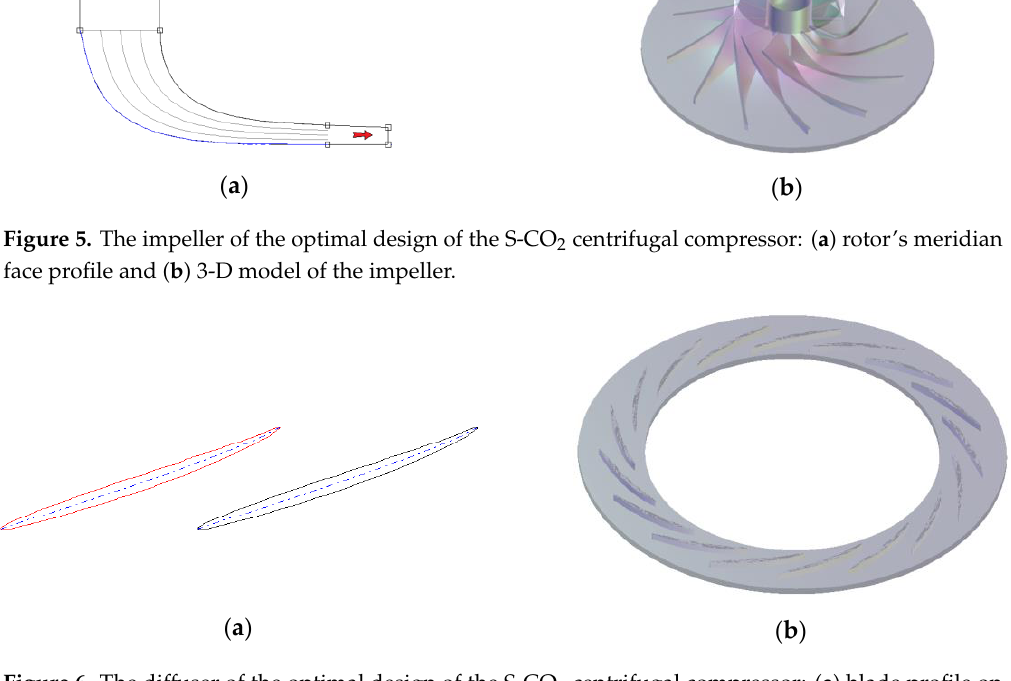
Figure 6. The diffuser of the optimal design of the S-CO 2 centrifugal compressor: ( a ) blade profile on the B2B cross section and ( b ) 3-D model of the diffuser.